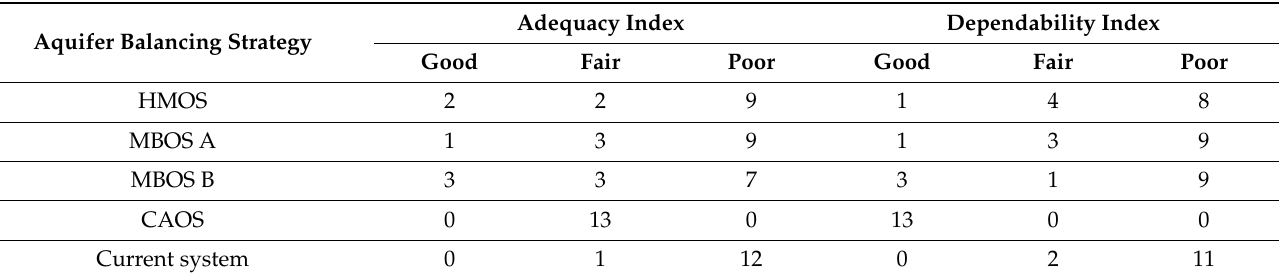
Table 4. Number of reservoirs in the Nekouabad surface water distribution system in each category of adequacy and dependability indices of water distribution after the application of the strategies according to the 15% drought